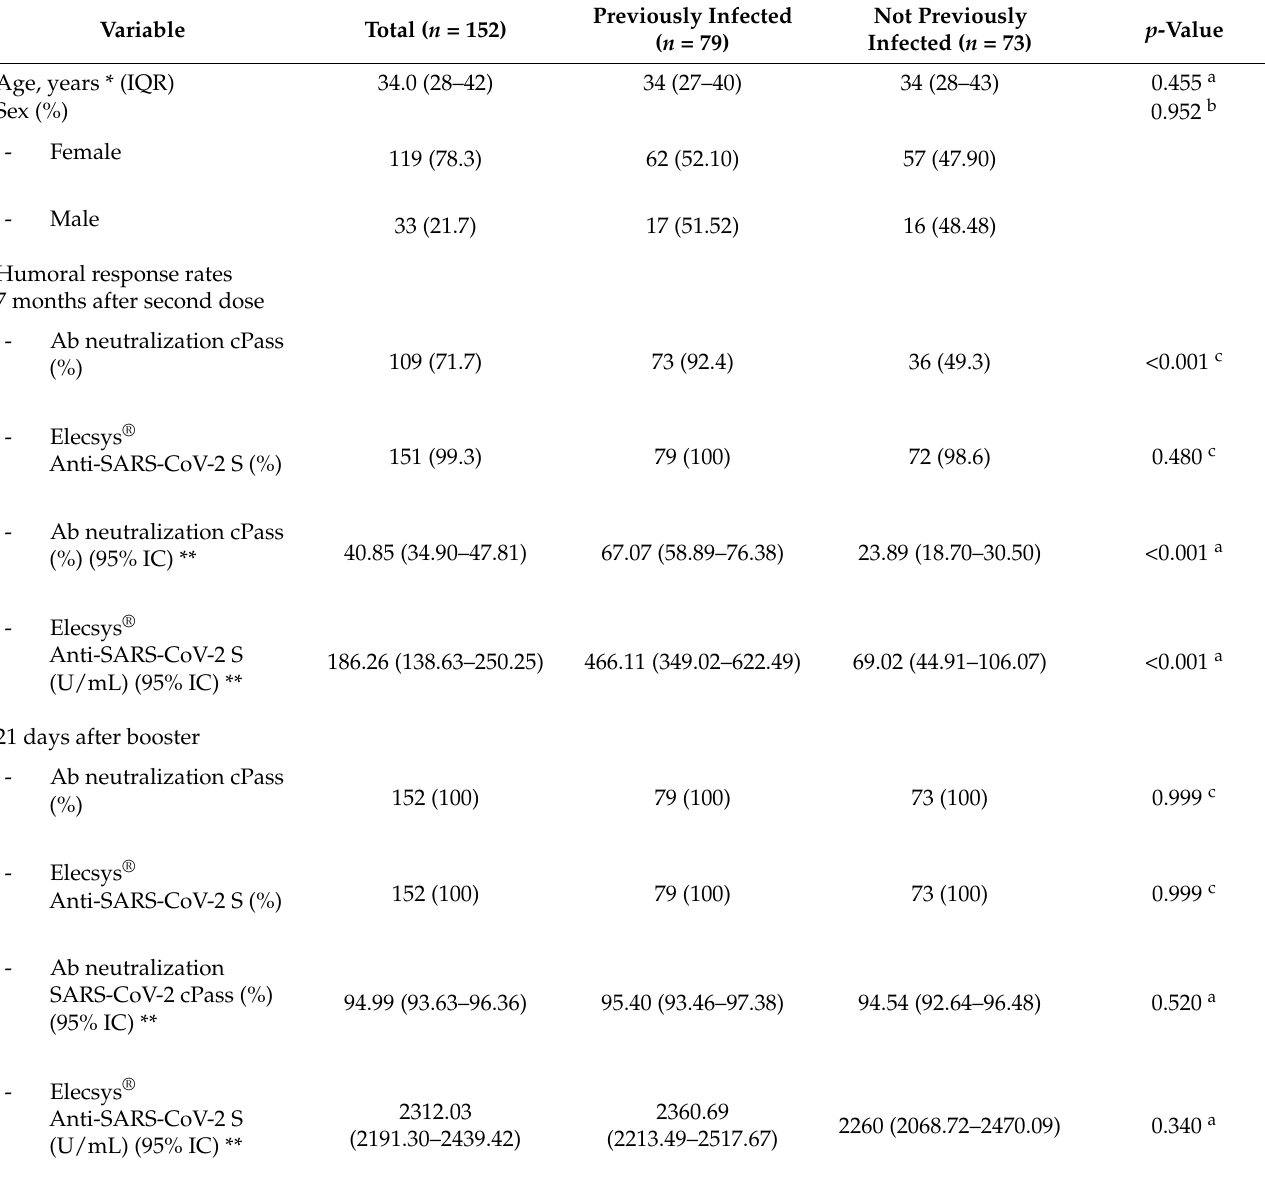
Table 1. Demographic characteristics, humoral response rates by SARS-CoV-2 specific antibody levels before and after BNT162b2 booster of the study population and comparison between previously infected and previously